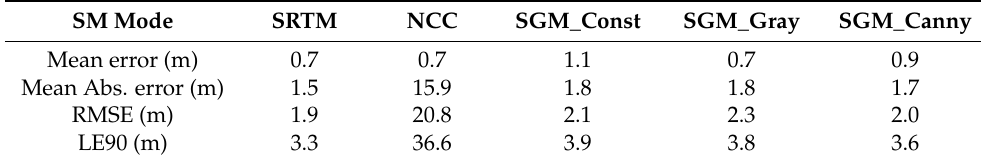
Table 9. Height accuracy of DSM generated from Stripmap stereo pair in test area